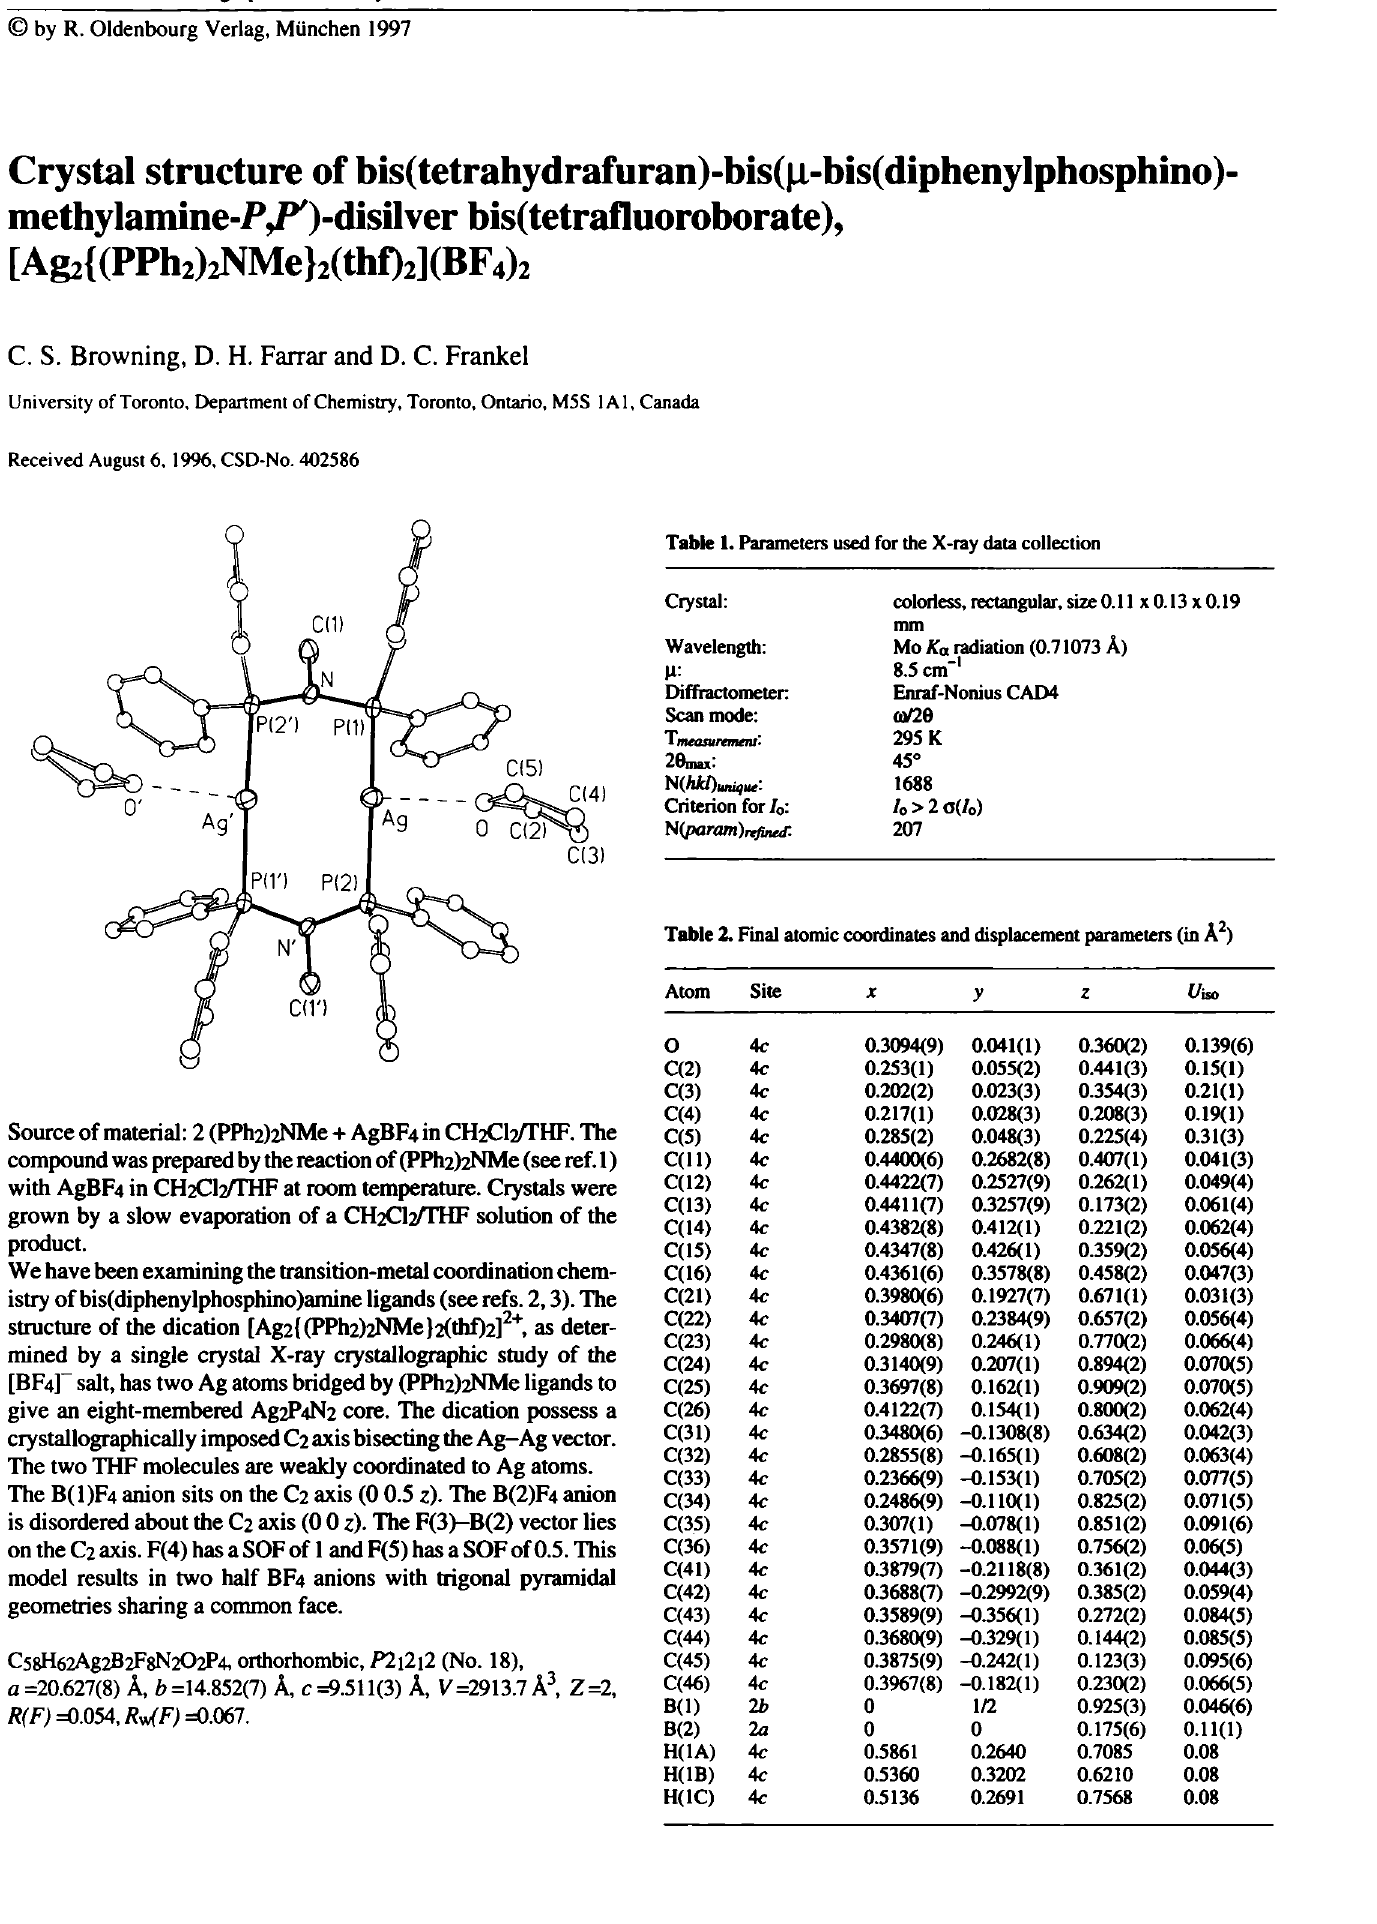
Table I. Parameters used for the X-ray data collection